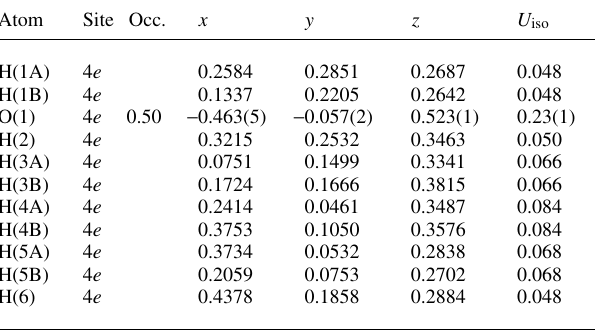
Table 2. Atomic coordinates and displacement parameters (in Å 2 )